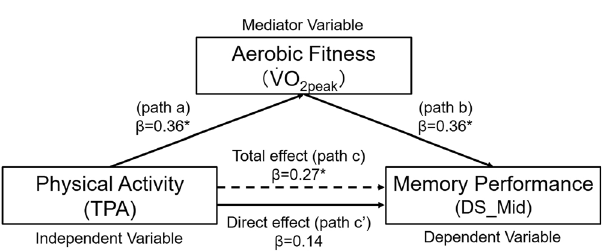
Figure 4. Mediation model. Aerobic fitness (  V O 2peak ) as a mediator of the effect of physical activity on discrimination score for middle-similarity lures (DS_Mid). Path c: total effect of TPA on DS_Mid; path a: effect of TPA on  V O 2peak ; path b: effect of mediator on DS_Mid; path c ′ : direct effect of TPA on DS_Mid through a mediator. Sex was entered as a covariate for all paths. β indicates standardized regression coefficient. * p < 0.05, ** p < 0.01.